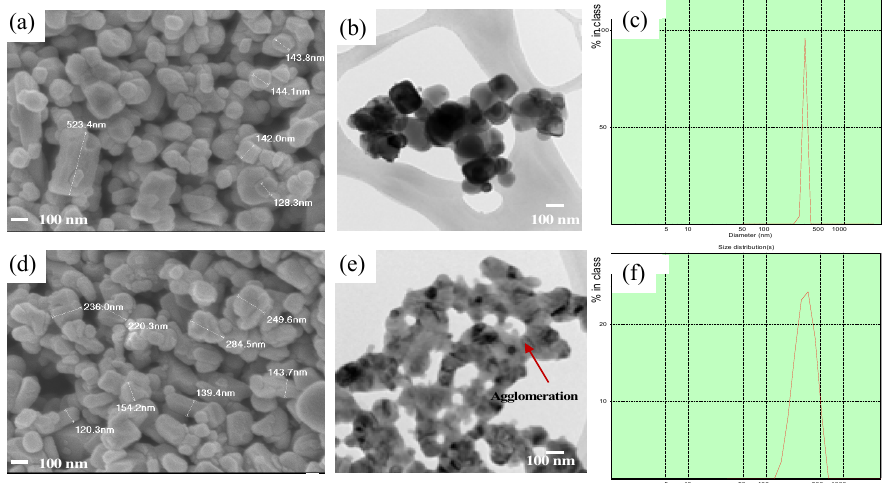
Figure 3. SEM morphology, TEM image and Particle size distribution of powder sample which calcine in the same temperature at 900 °C with different synthesis routes ( a – c ) sol-gel method and( d – f ) solid state reaction method.